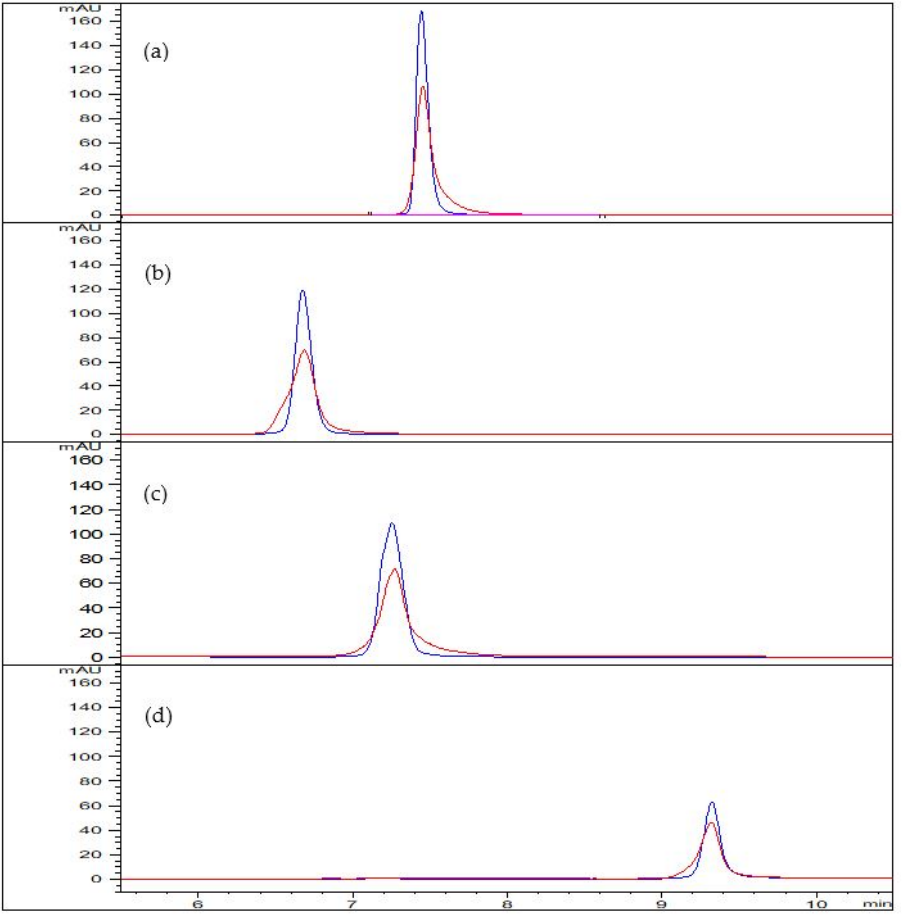
Figure A4. Comparison of optimized RP-HPLC methods on selected columns: ( a ) BioZen™ Intact